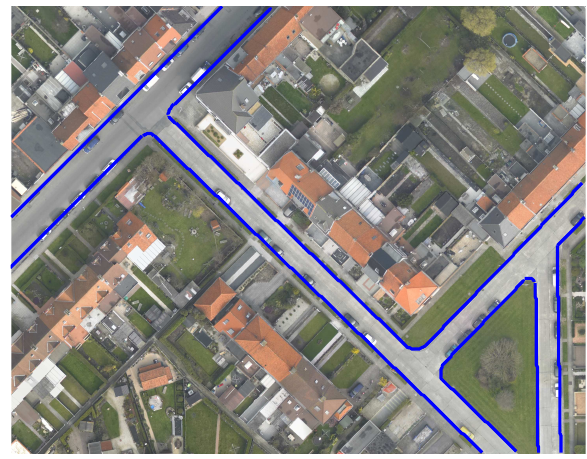
Figure 5: Visualization of the extracted road network and the roads’ delineation using our proposed method.